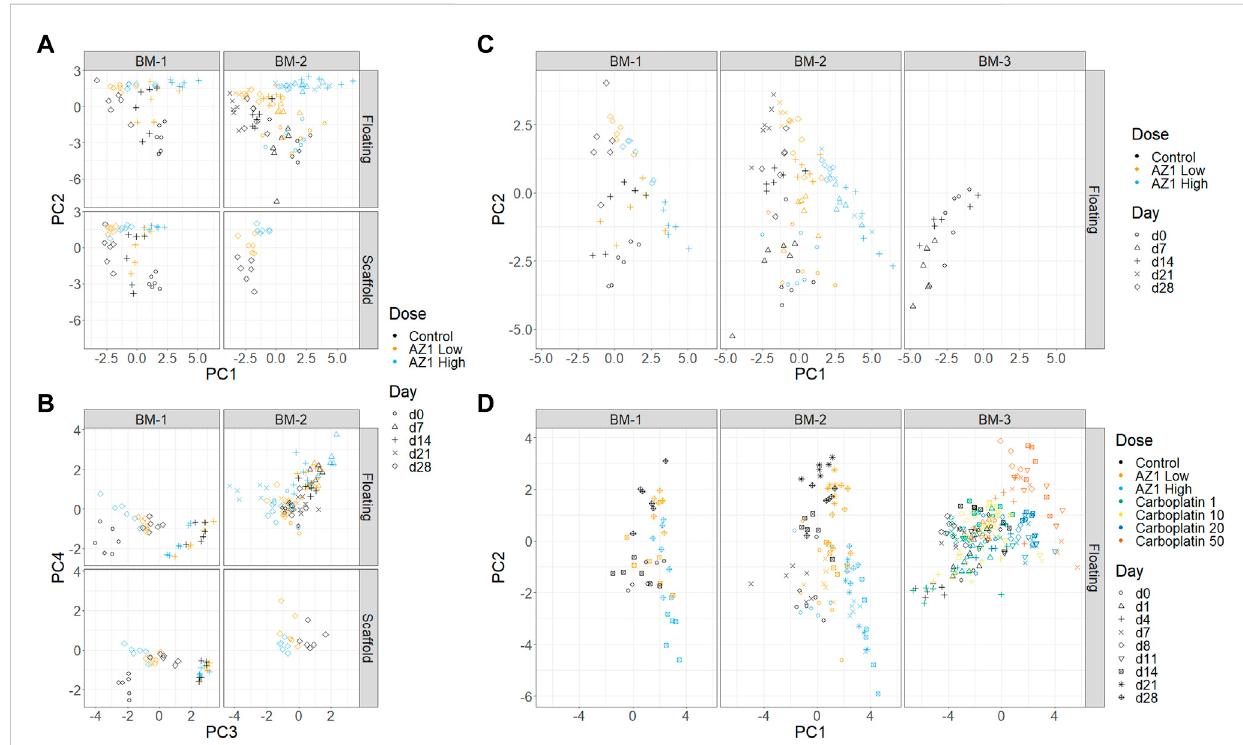
FIGURE 5 Dimensionality reduction. Principal Component Analysis (PCA) performed on subsets of the three experiments. (A) and (B) Experiments BM-1 and BM-2 (AZ1 repeats), showing PCs 1 and 2 (A) and PCs 3 and 4 (B) . (C) Experiments BM-1, BM-2 and BM-3 (control only). (D) All of the